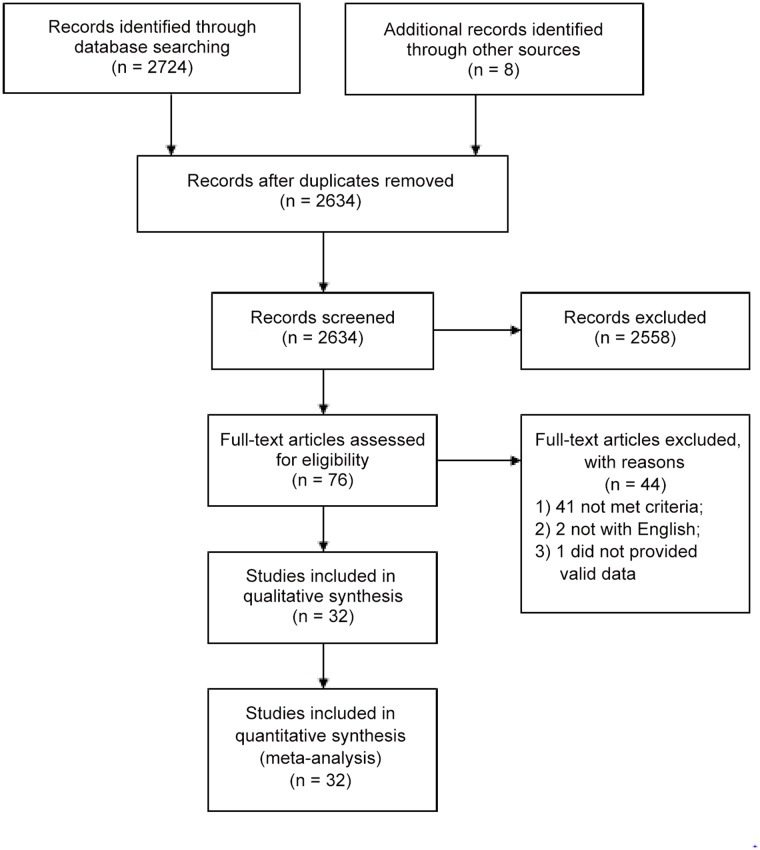
Flow diagram of the literature search.